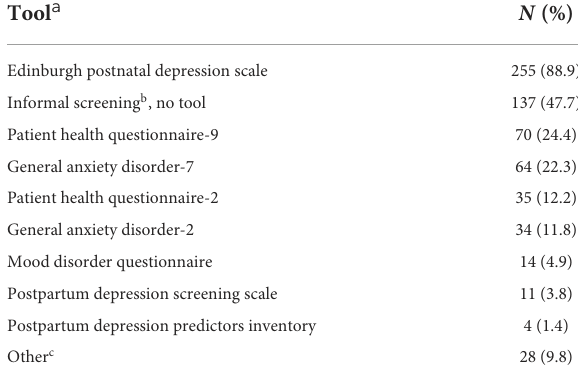
TABLE 2 PMHD screening tools reportedly used by